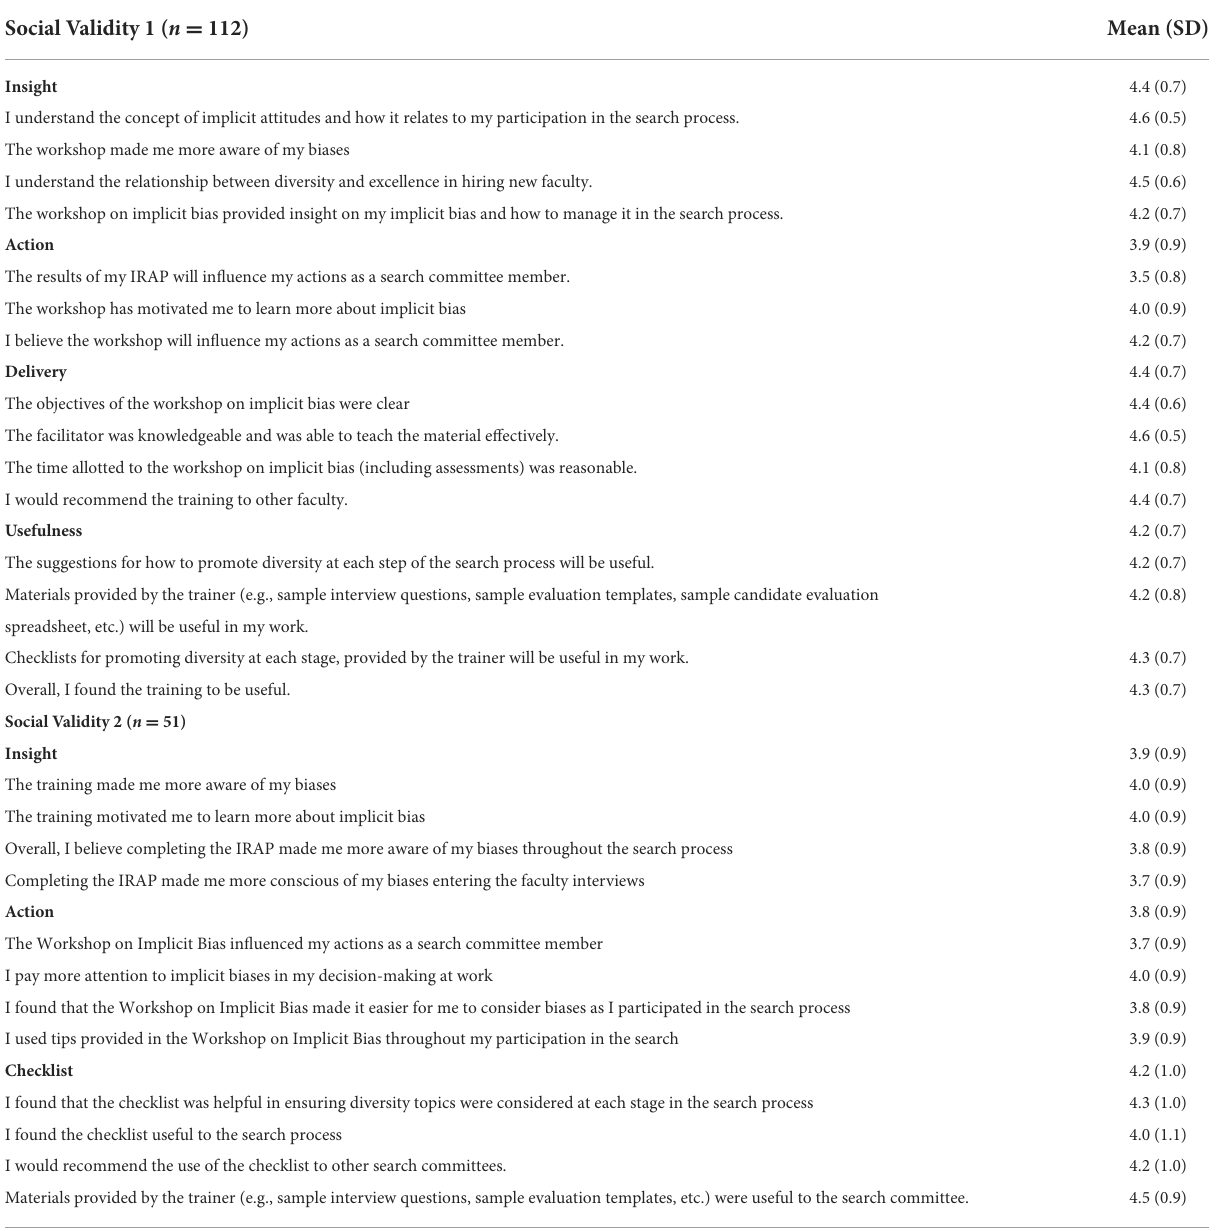
TABLE 2 Means and standard deviations for post-workshop social validity surveys (SV1 &